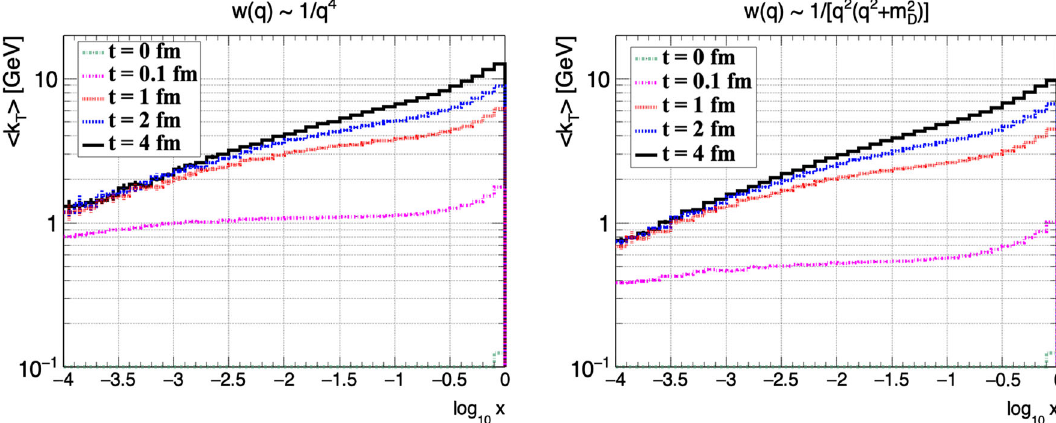
Fig. 5 The (cid:10) k T (cid:11) v.s. log 10 x distributions from the Monte Carlo program MINCAS for the evolution time values: t = 0 , 0 . 1 , 1 , 2 , 4fm. The LHS figures are for w( q ) of Eq. (5), while the RHS ones for that of Eq.